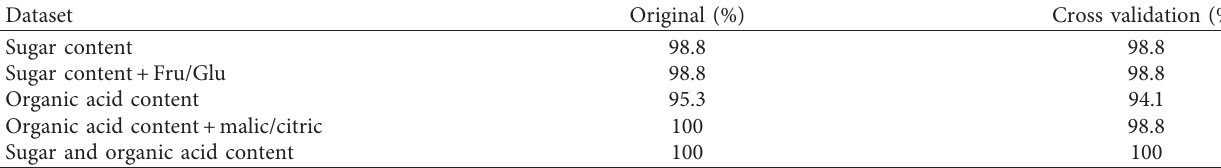
Table 3: Correct classification rate by LDA with different datasets of predictors.